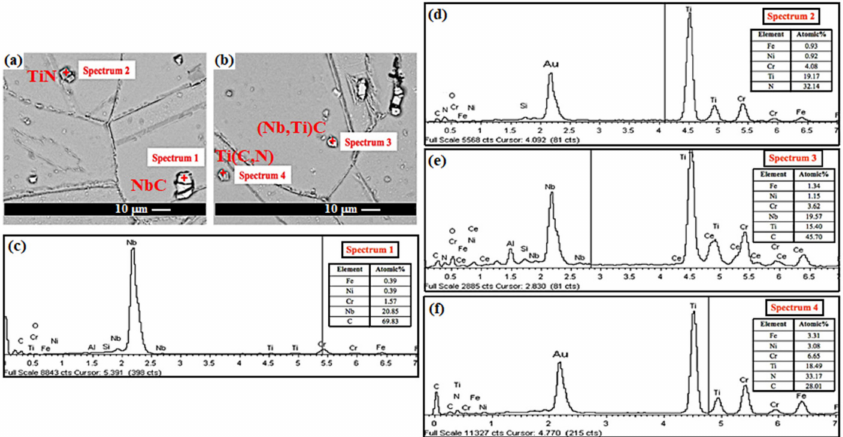
Figure 10. ( a , b ) FESEM images and and corresponding EDX spectra of the alloy from ( c ) spectrum 1, ( d ) spectrum 2, ( e ) spectrum 3 and ( f ) spectrum 4 of Fe-40Ni-24Cr creep test at 800 ◦ C under 100 MPa